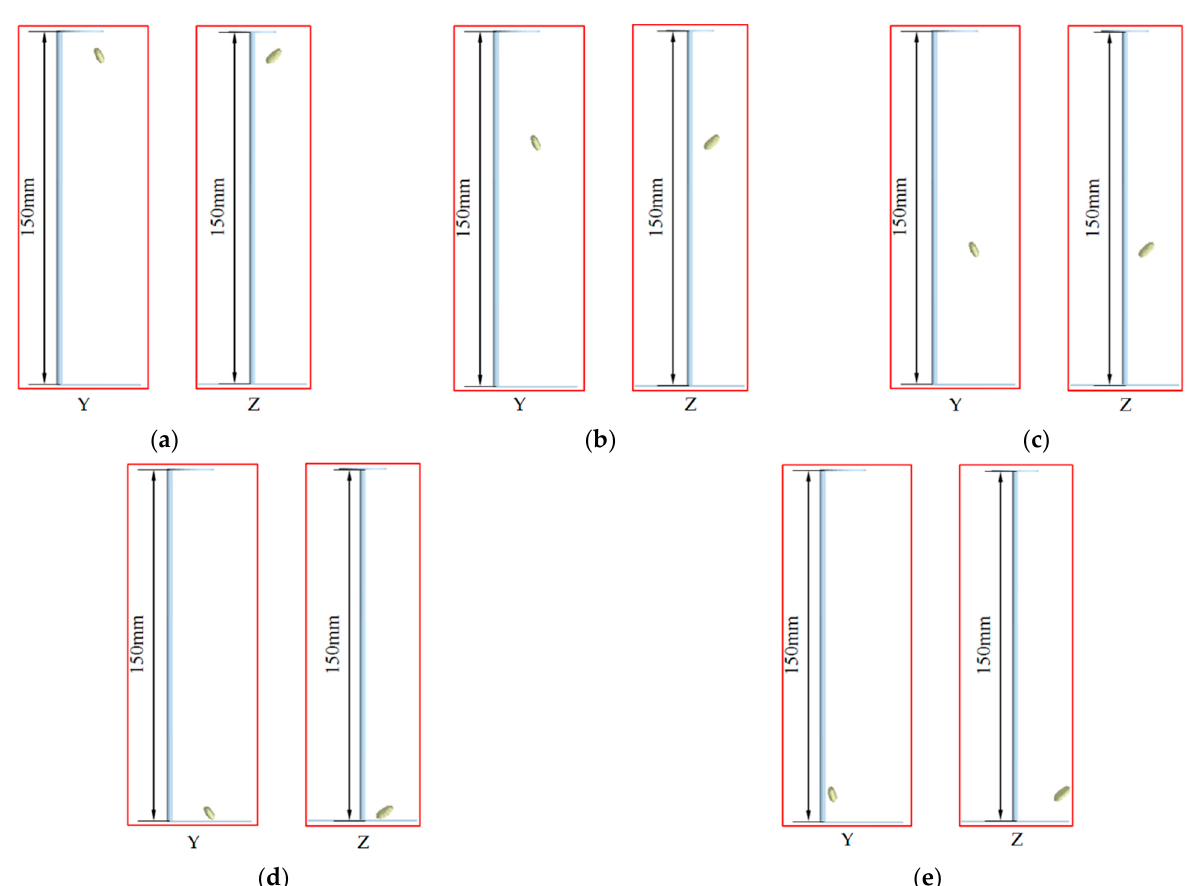
Figure 10. Rice grain bouncing state of simulation test. The picture shows the falling state of grains at different times: Y is the Y direction, and Z is the Z direction. ( a ) 0.01s; ( b ) 0.04 s; ( c ) 0.07 s; ( d ) 0.10 s; and ( e ) 0.13 s.